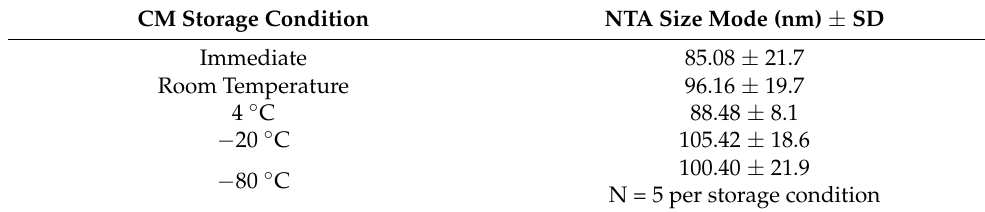
Table 1. NTA Size of EVs by Storage Condition.